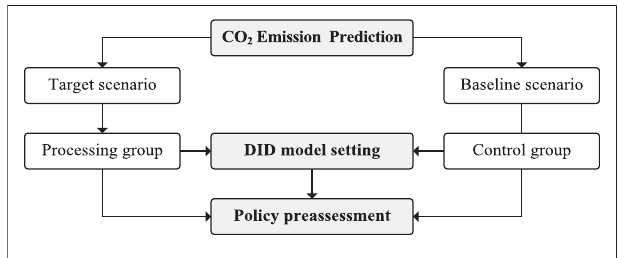
FIGURE 1 | Research